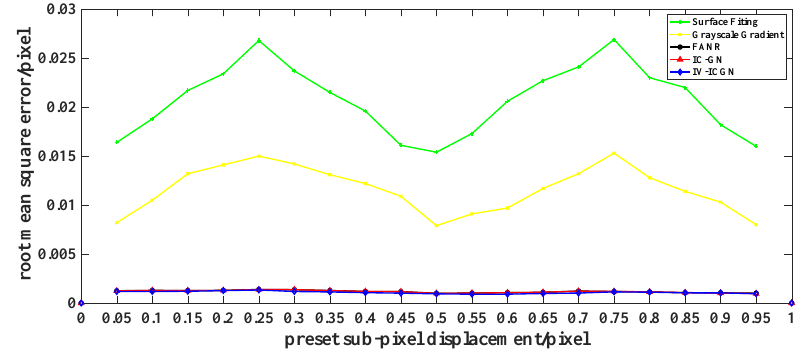
Figure 8. Comparison curve of the RMSE in the u direction of five algorithms.